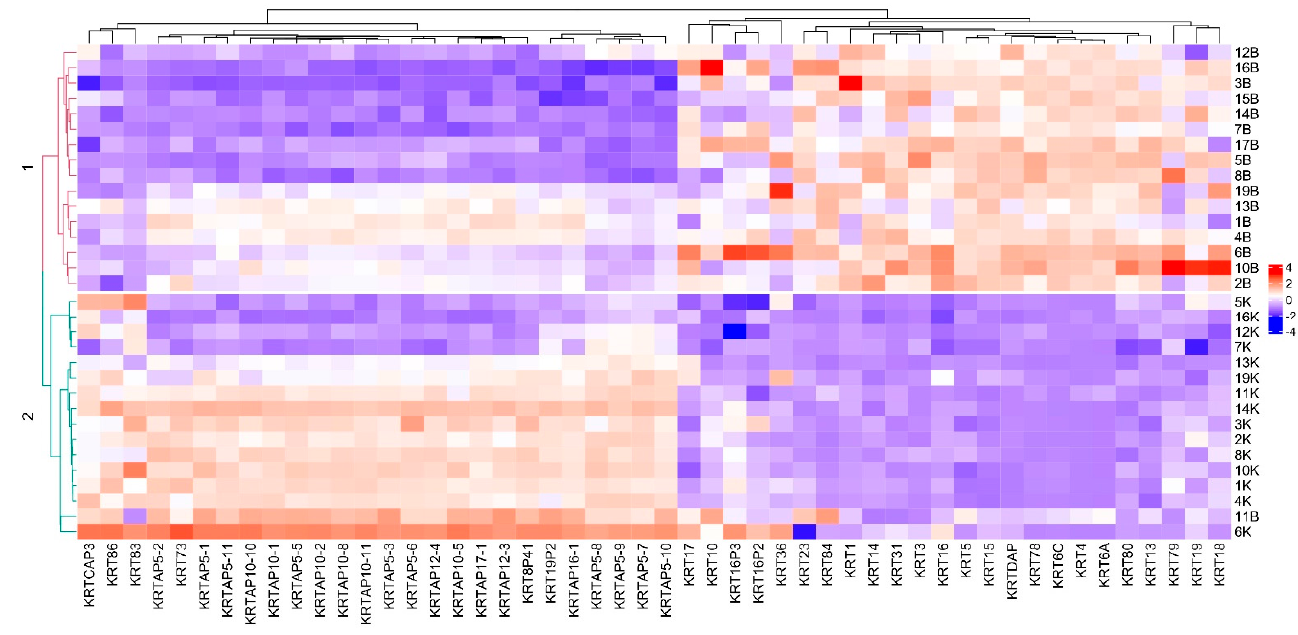
Figure 5. Heatmap of the expression of keratins in bladder body and urothelium samples. The expression of each gene was log-normalized for visualization using DESEQ2 function rld and scaled with an R function scale. Table 2. Relative levels of expression of individual genes selected from the transcriptome data previously reported as being specifically expressed in human urothelium